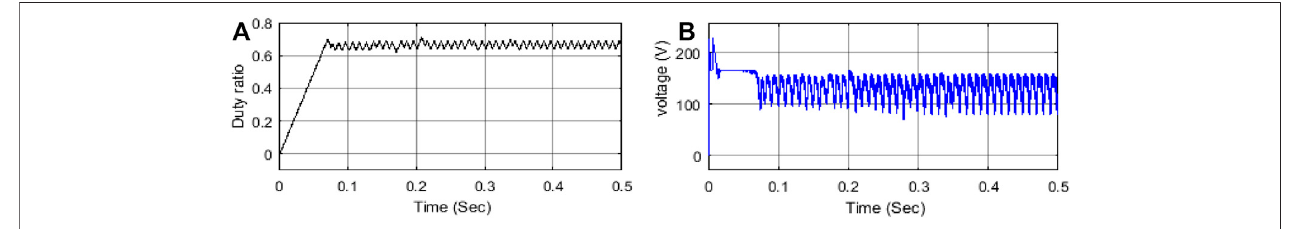
FIGURE 10 | (A) Duty ratio and (B) VSI output.